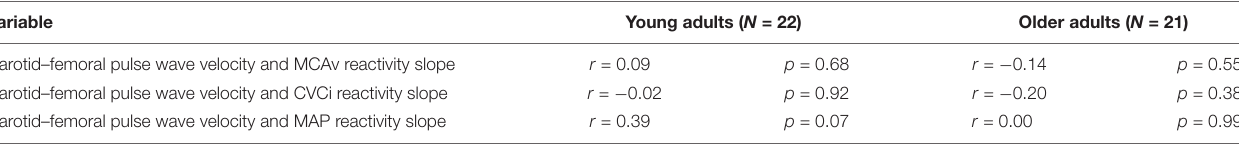
TABLE 2 | Associations between cerebrovascular reactivity and central arterial stiffness.